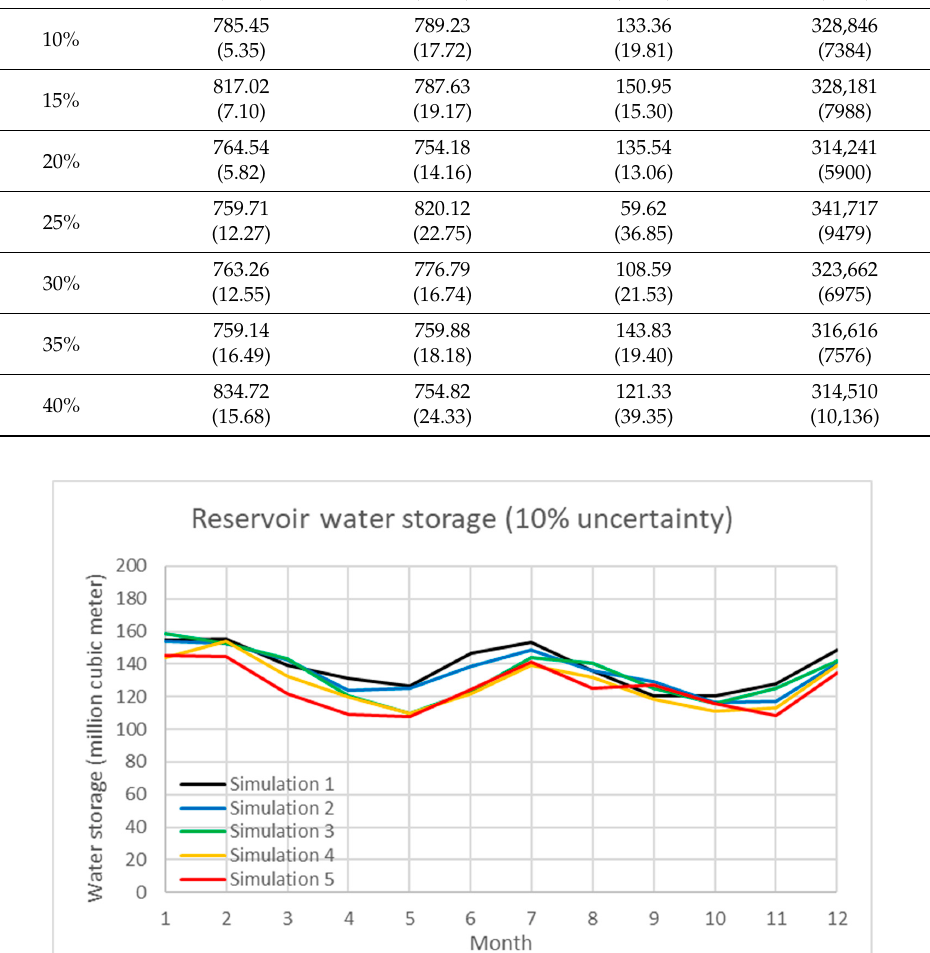
Figure 4. Simulation results of water storage in the Shihmen Reservoir under 10% uncertainty of water inflow.